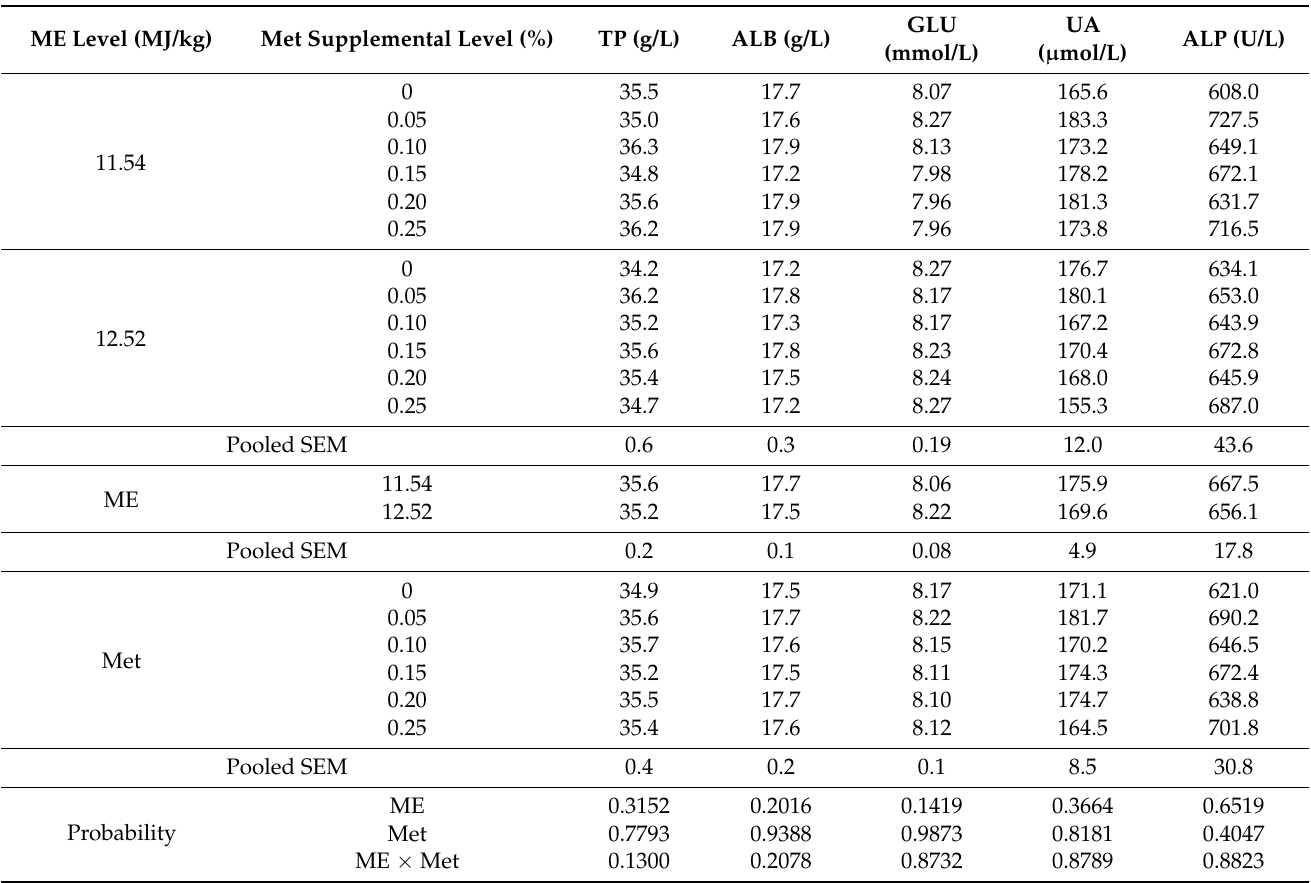
Table 6. Effects of dietary metabolizable energy and methionine levels on hepatic damage and function-related biochemical parameters of starter Pekin ducks at 21 days of age 1